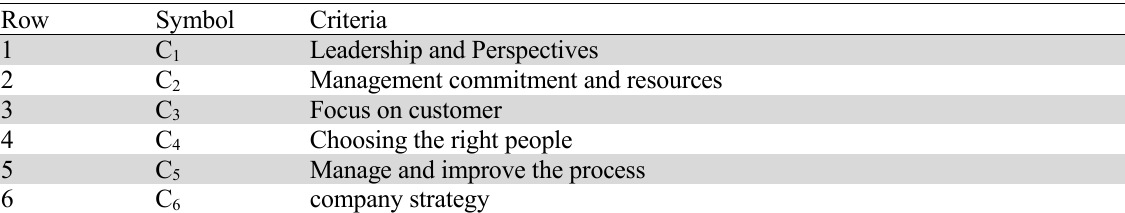
List of the criteria